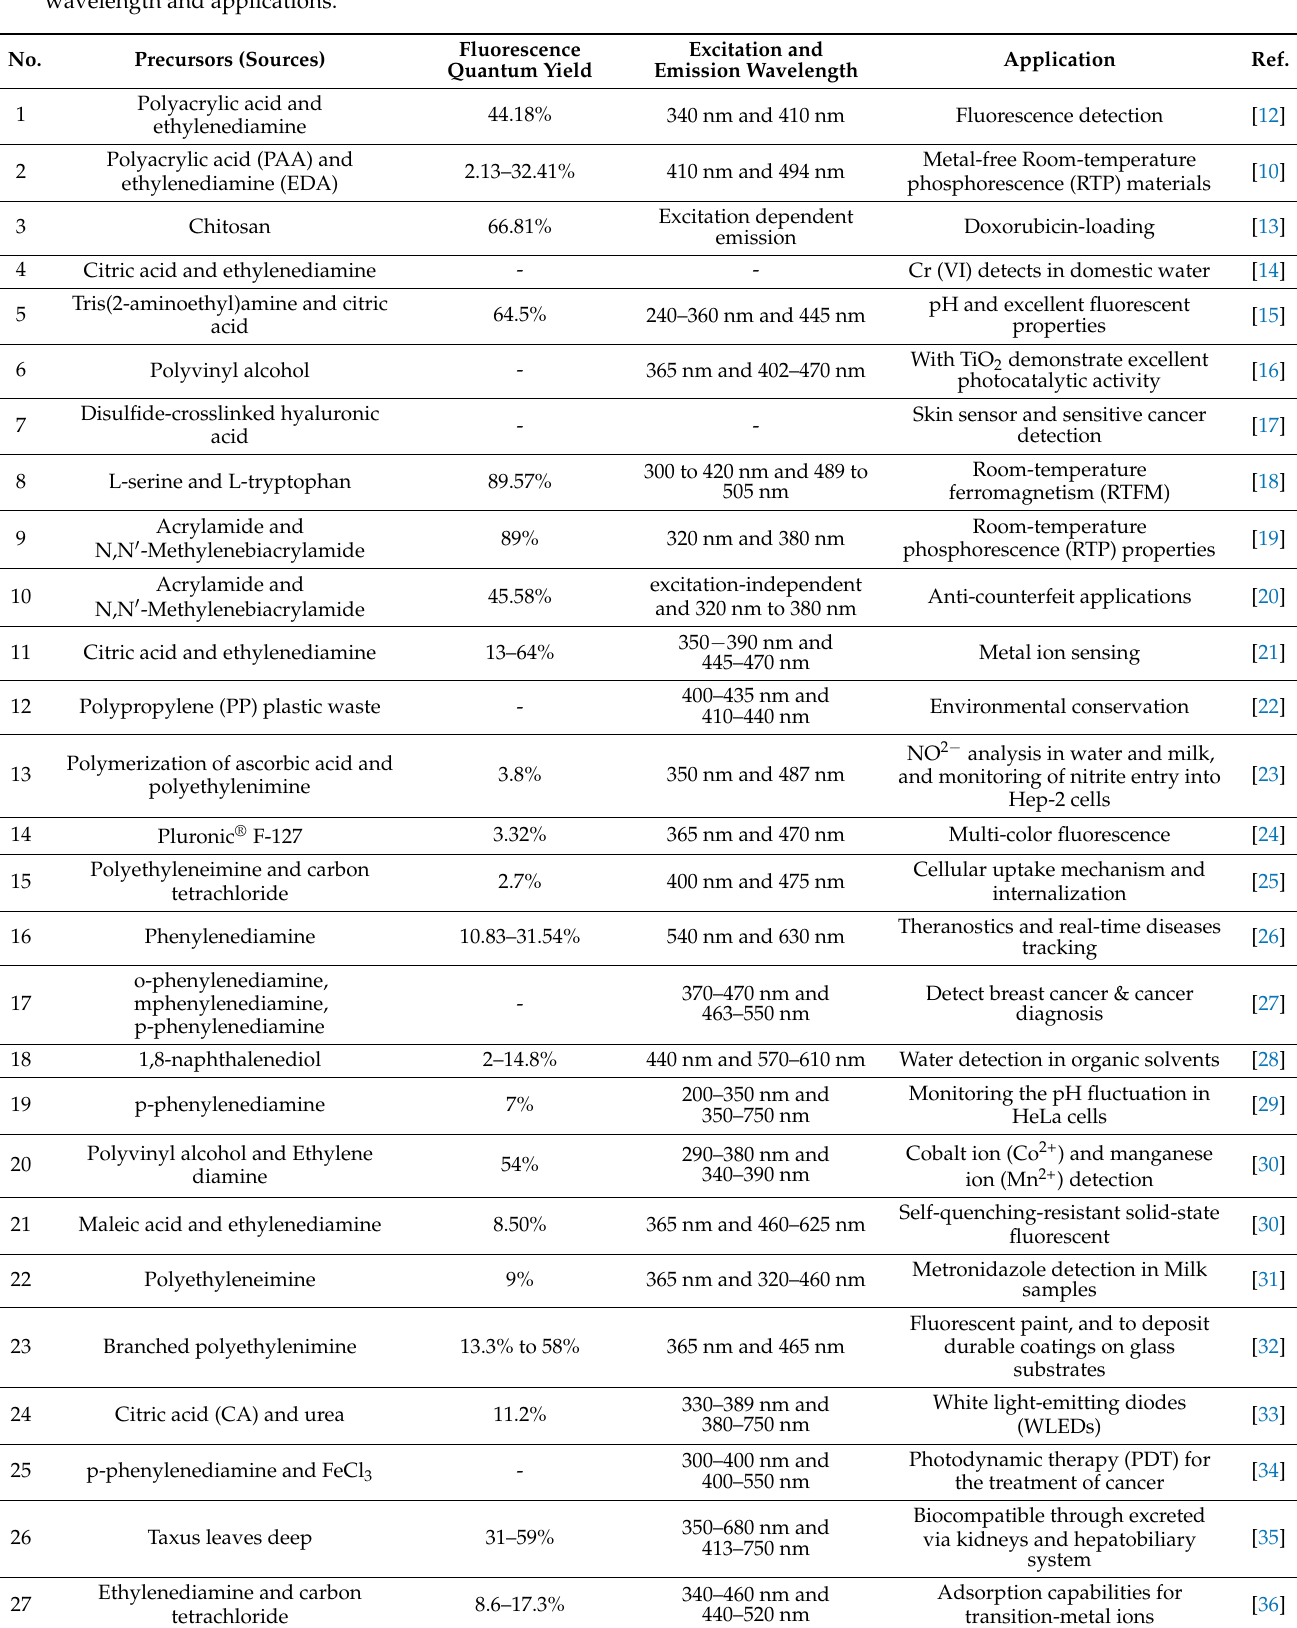
Table 2. The representative examples of CPDs and their fluorescence quantum yield (QY), excitation and emission wavelength and